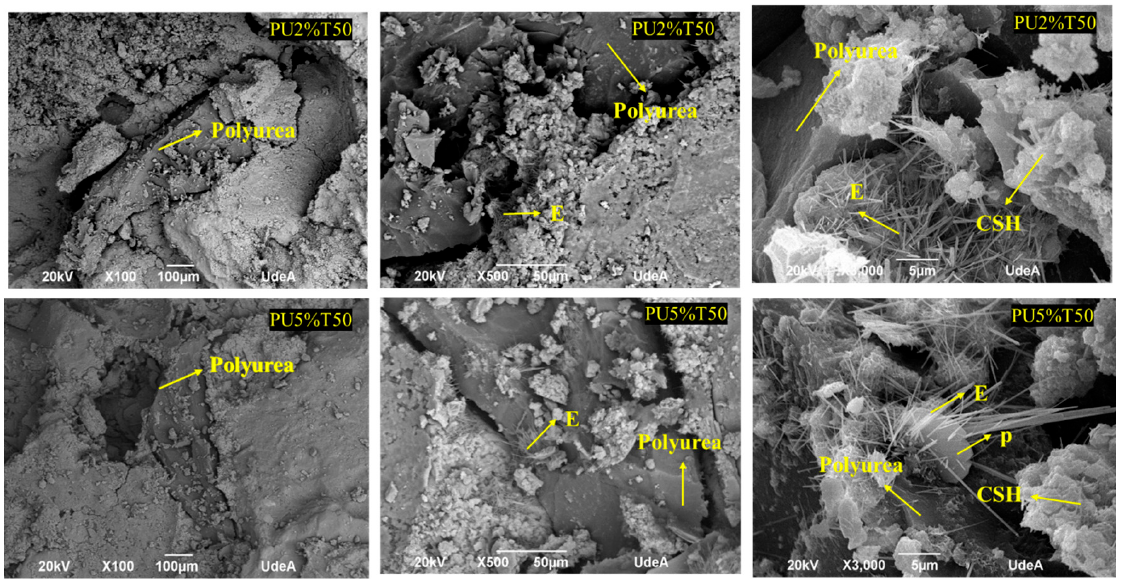
Figure 6. SEM analysis of mortars with polyurea retained in sieve 50 (PU2%T50 and PU5%T50).